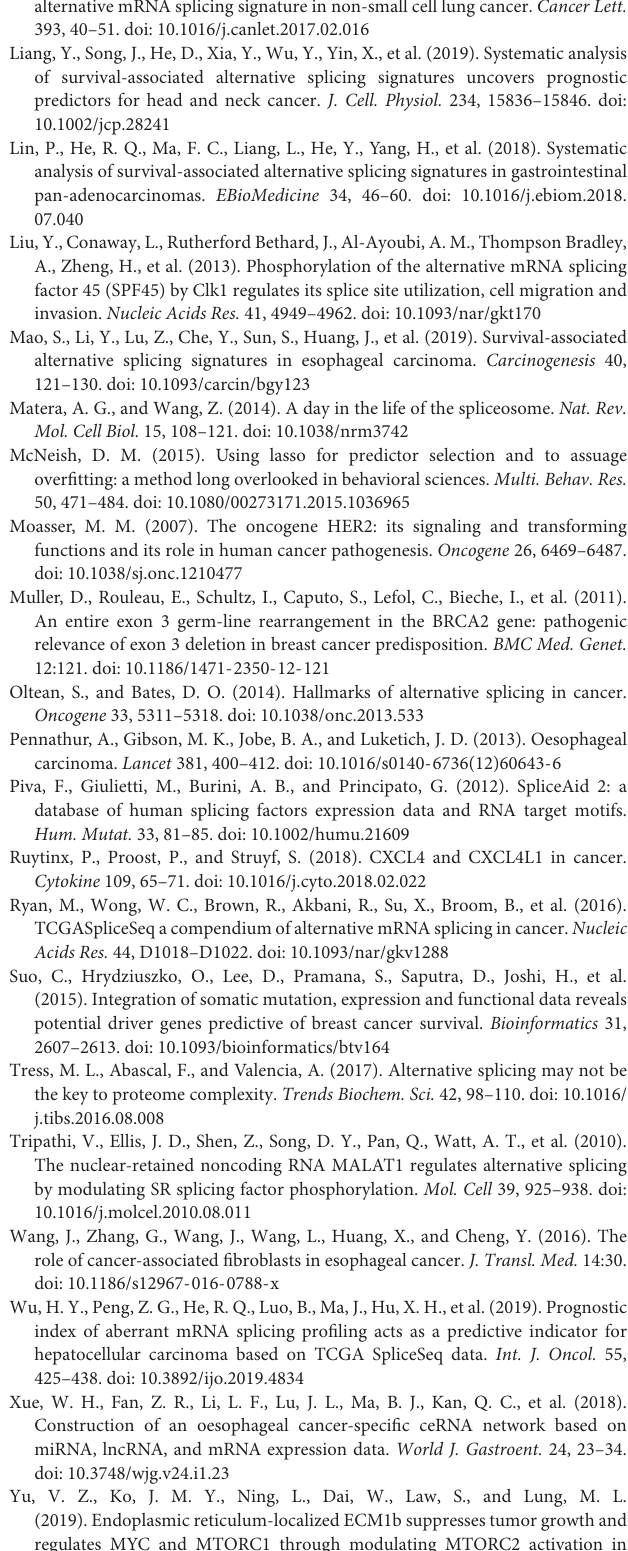
doi: 10.3748/wjg.v24.i1.23 Yu, V. Z., Ko, J. M. Y., Ning, L., Dai, W., Law, S., and Lung, M. L. (2019). Endoplasmic reticulum-localized ECM1b suppresses tumor growth and regulates MYC and MTORC1 through modulating MTORC2 activation